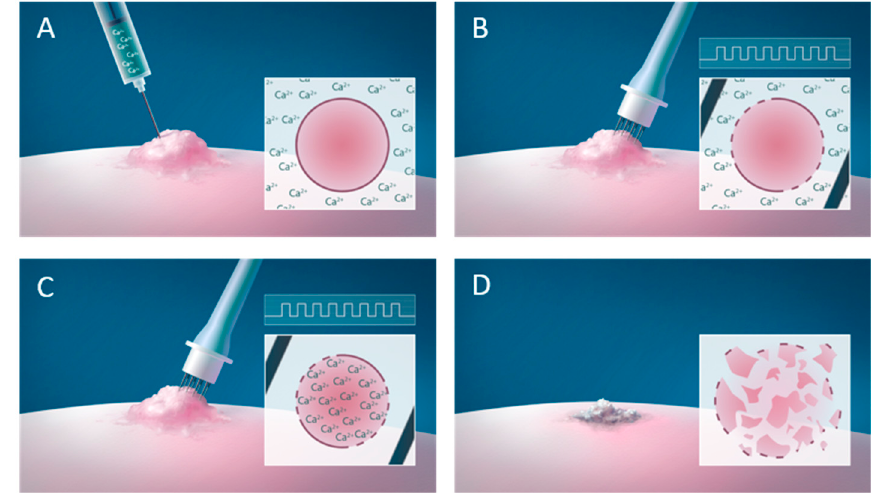
Figure 1. Calcium electroporation. ( A ) Calcium is injected in the tumor causing a high extracellular calcium concentration. ( B ) Immediately after the injection, the tumor is electroporated using an electrode (e.g. needle electrode) causing transient permeabilisation of the cell membrane allowing passage of calcium into the cell ( C ) causing cancer cell death ( D ).